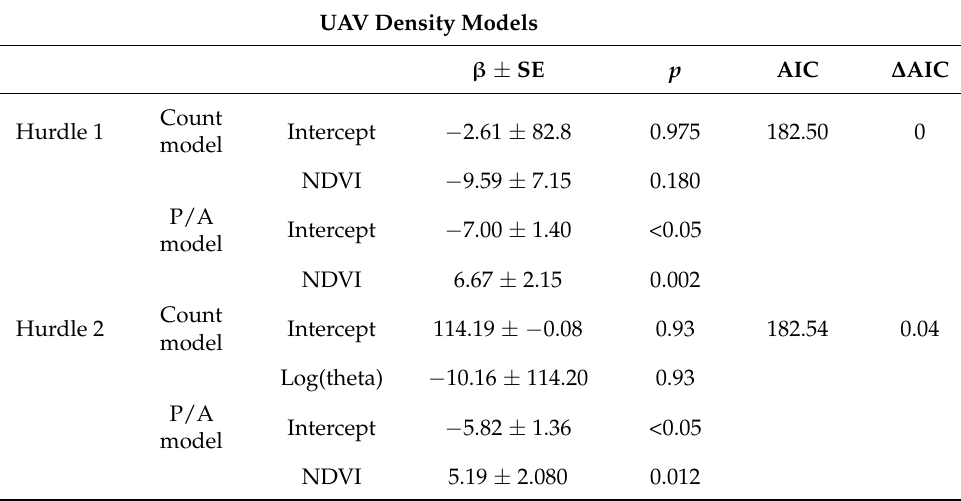
Table A4. UAV density model obtained from UAV sampling in Sassendalen in 2021. We used the most parsimonious density model from Le Moullec et al. [22], which modelled individuals per segment as a function of NDVI using a Hurdle density model with a zero-truncated negative binomial distribution with a dispersion parameter. Displayed below are the two candidate models with lowest AIC. Both models were fitted using the restricted maximum likelihood (REML). The simplest of the two models, Hurdle model 2, was selected for the